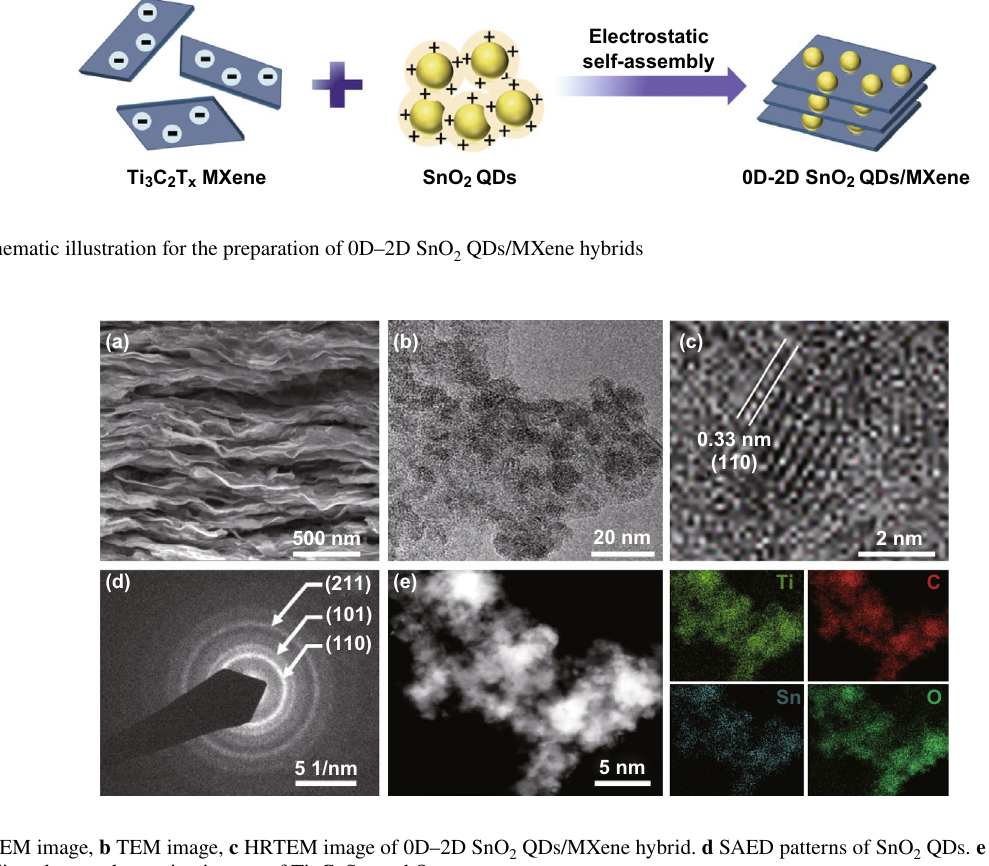
Fig. 2 a SEM image, b TEM image, c HRTEM image of 0D–2D SnO 2 QDs/MXene hybrid. d SAED patterns of SnO 2 QDs. e STEM image and corresponding elemental mapping images of Ti, C, Sn, and